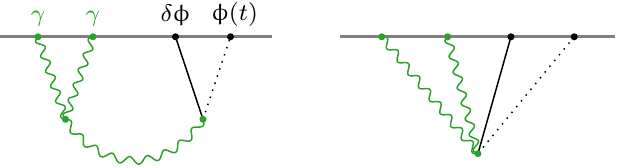
Figure 12: Illustration of the inflationary tensor-tensor-scalar bispectrum arising from the soft limit of a de Sitter